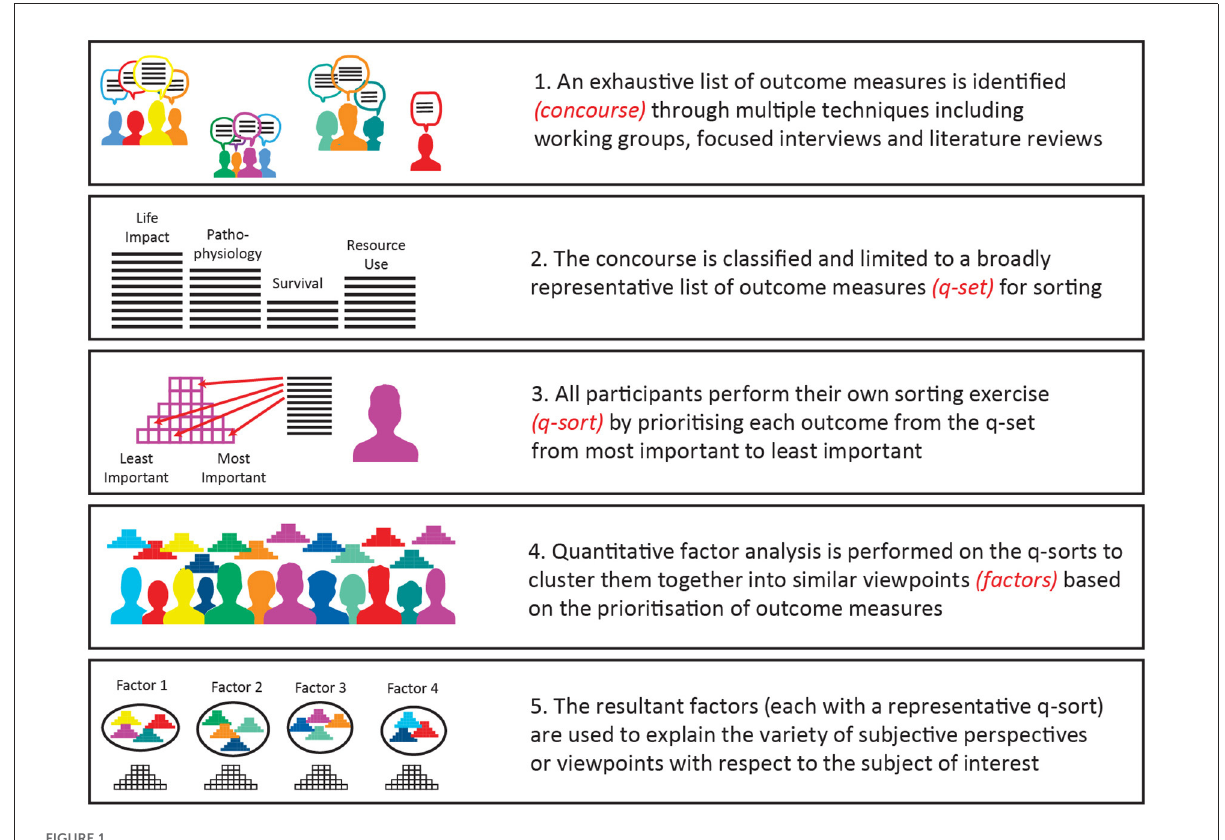
FIGURE1 Overview of